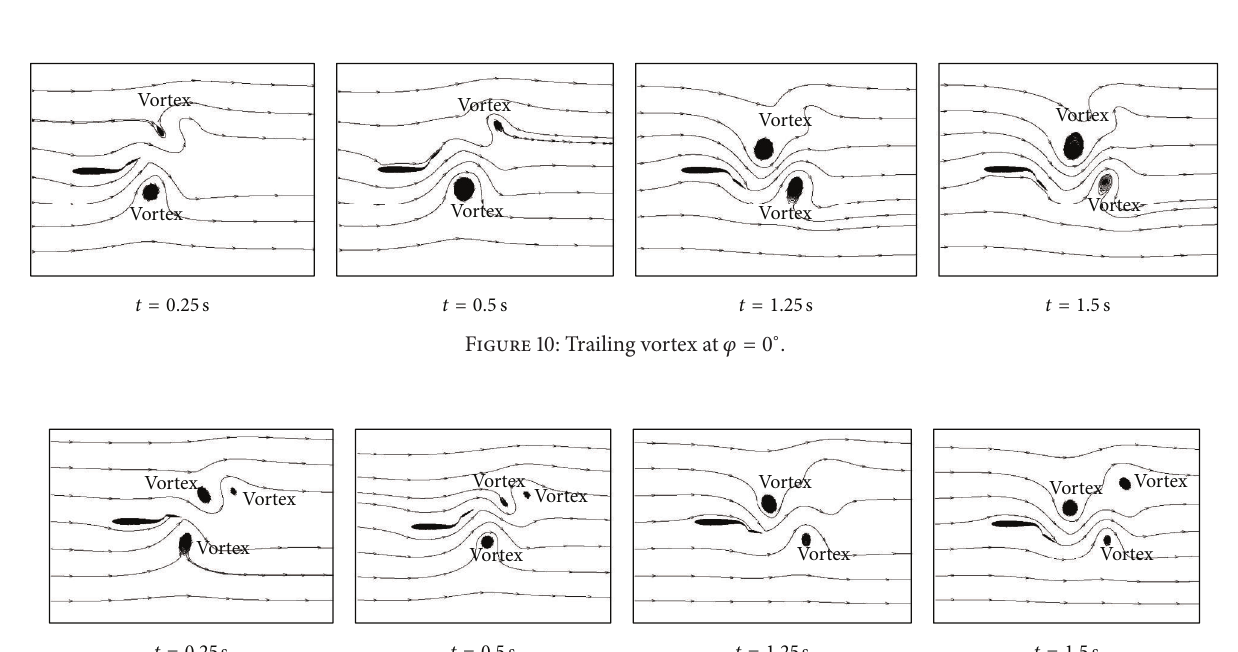
Figure 9: Influences of various 𝜑 , 𝑠 , and 𝜀.